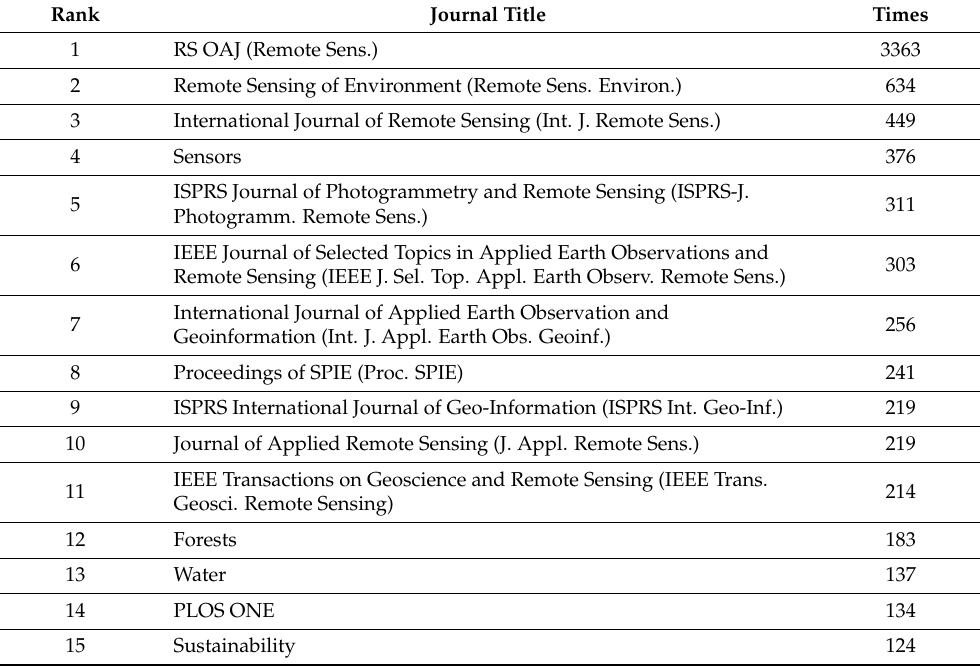
Table 12. The articles of the Journals that are cited in RS OAJ articles frequently (Top 15).